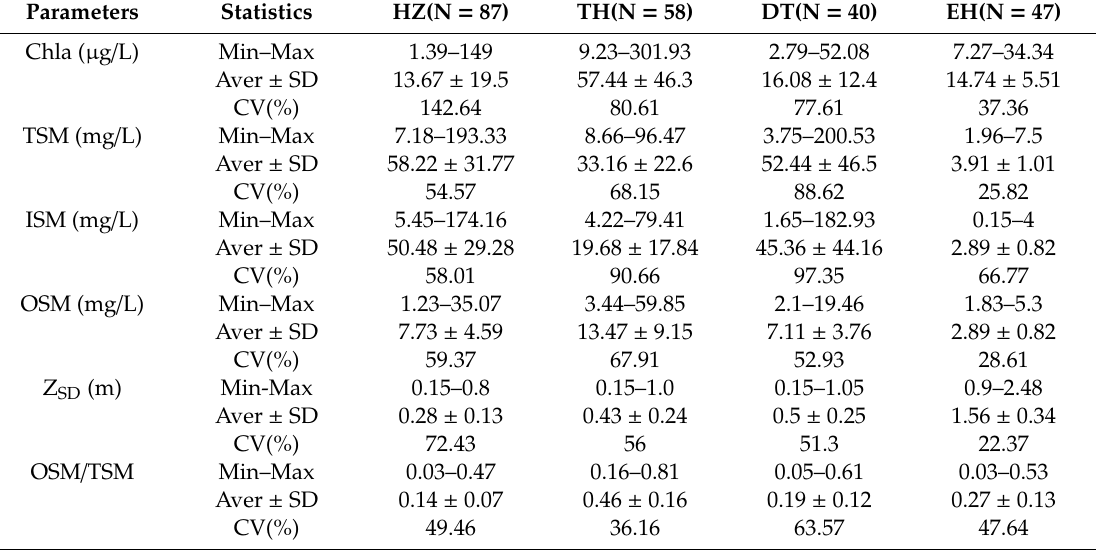
Table 2. Descriptive statistics from Lake Hongze (HZ), Lake Taihu (TH), Lake Dongting, and Lake Erhai (EH).